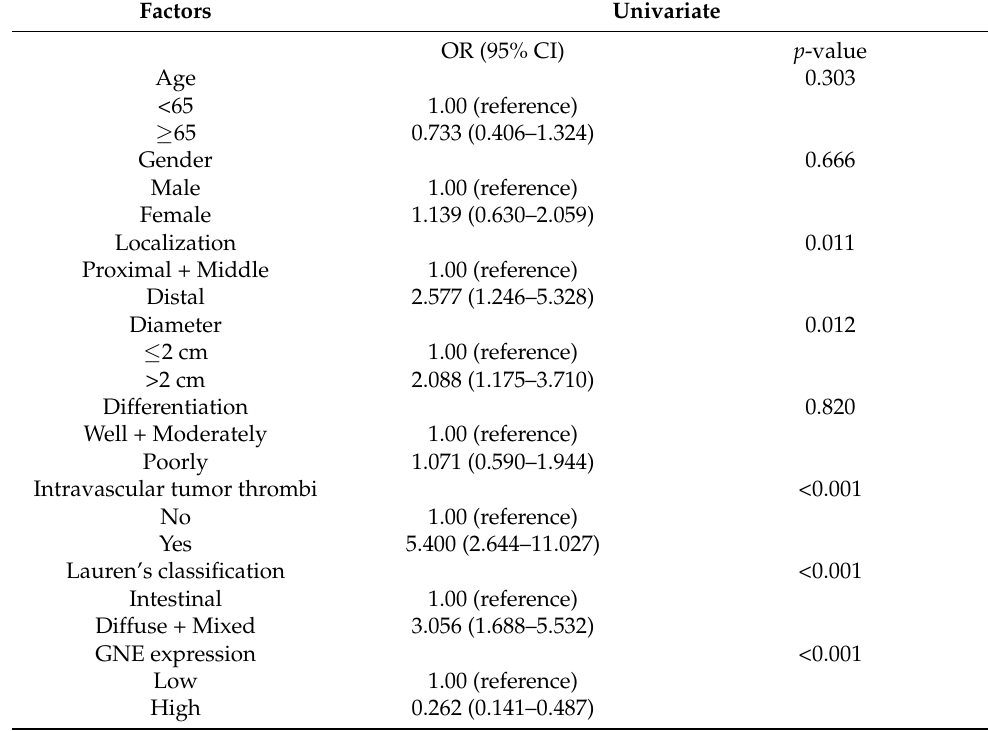
Table 3. Univariate logistic regression analyses for lymph node metastasis in